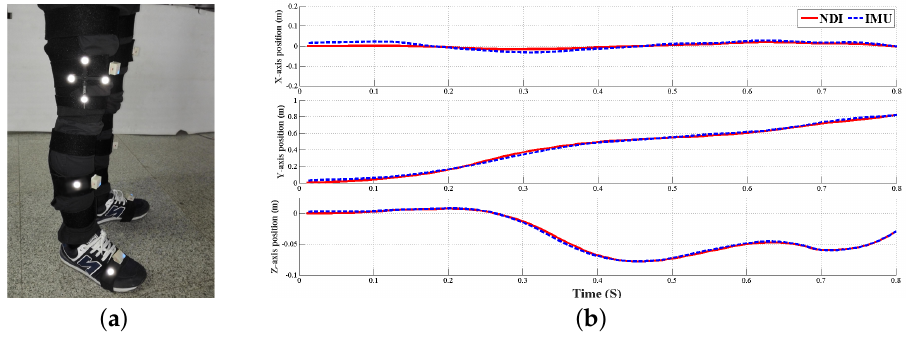
Figure 9. System accuracy validation by an NDI Polaris Spectra System ( a ) sensor placement and reflection points of optical system; ( b ) error statistics of a three-dimensional thigh sensor position estimation for random lower limbs’